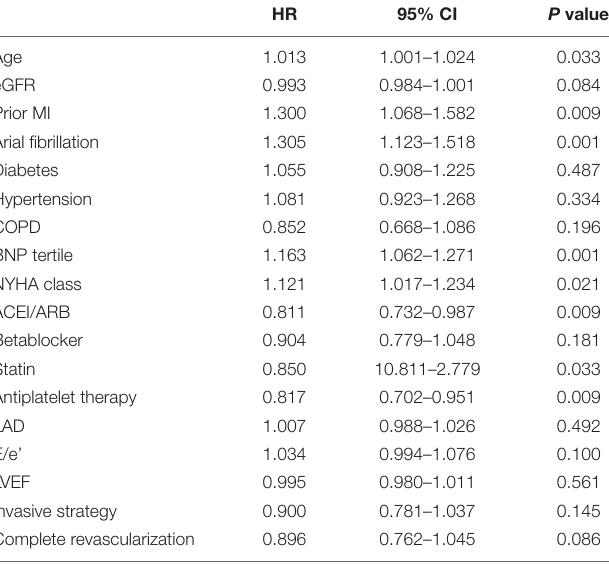
TABLE 4 | Multivariable cox analysis for composite endpoints.